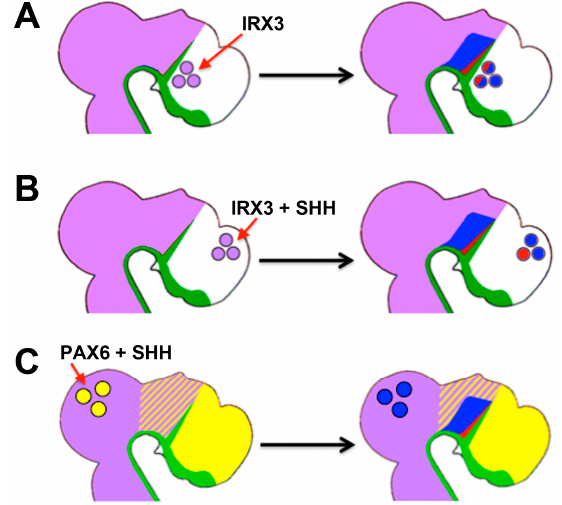
Figure 5. IRX3 and PAX6 endow cells with competence for the induction of thalamic neurons by SHH. ( A ) Ectopic expression of IRX3 (purple) anterior to the ZLI results in a mirror-image duplication of GABAergic (red) and glutamatergic (blue) neurons of the thalamus in the prethalamus. These inductions depend on SHH signalling [143]. ( B ) Ectopic expression of IRX3 in the dorsal telencephalon results in induction of GABAergic and glutamatergic thalamic neurons, but only if the SHH pathway is simultaneously activated. ( C ) Ectopic expression of PAX6 (yellow) and simultaneous activation of the SHH pathway results in induction of thalamic neurons in the dorsal midbrain, suggesting that the overlap of IRX3 and PAX6 defines the competence domain for thalamus formation in response to SHH [148].